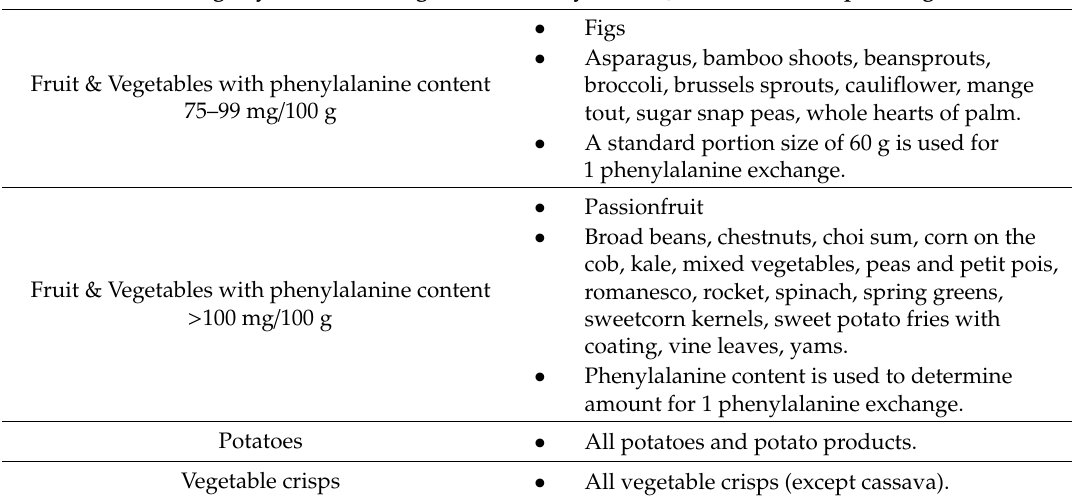
Table 4. Category 4: Exchange fruit and vegetables (phenylalanine > 75 mg / 100 g). 4. Exchange Fruit / Vegetables Containing Phenylalanine > 75 mg / 100 g Allocated as Part of the